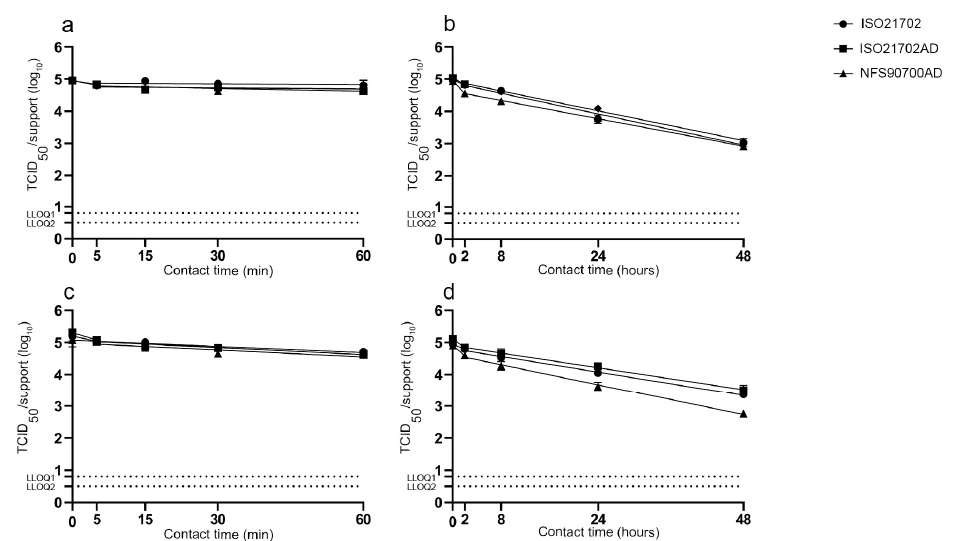
Figure 1. Survival of enveloped H3N2 virus ( a , b ) and non-enveloped feline calicivirus ( c , d ) on stainless steel reference surfaces according to ISO21702, ISO21702AD and NFS90700AD protocols. LLOQ: lower limit of quantification (LLOQ2 = 0.5 log 10 TCID 50 for 21702/21702AD methods and LLOQ1 = 0.8 log 10 TCID 50 for NFS90700AD method). Value displayed as average +/ − SD. The amount of H3N2 infectious virus on the AS01 surface reached the lower limit of quantification at 48 h post application, whereas no H3N2 infectious particles were quantified at 24 h post application on the AS02 surface using all three protocols (Figure 2a,c). ISO21702 and ISO21702AD protocols gave similar values for the amounts of virus observed on AS01 at both 2 and 8 h post application. As observed on stainless steel supports at 24 h post application, the H2N2 virus was statistically the most stable on AS01 under ISO21702AD experimental conditions (Figure 2a). The NFS902700AD protocol had an impact on the survival of the H3N2 virus on AS01, as shown by the significantly reduced amount of infectious virus over time as compared to those quantified using ISO21702 and ISO21702AD protocols. The same impact was observed at 15 min and 8 h post application for AS03 and AS02, respectively (Figure 2c,e). A difference of 1 log 10 TCID 50 was observed on AS03 at 15 min post application, between NFS90700AD and ISO21702 or ISO21702AD protocols (Figure 2e). The antiviral activities Rm (log 10 TCID 50 /cm 2 ) of the three active surfaces, corresponding to the difference in the logarithm of the infectivity titer of H3N2 virus found on stainless steel supports versus antiviral-treated, were determined over time. While the antiviral activity of AS01 at 2 h post application showed no significant difference among the three protocols, antiviral activities were significantly higher at 8 and 24 h post application using the NFS90700AD compared to the ISO21702/ISO21702AD protocols (Figure 2b). While all three protocols revealed similar antiviral activities for AS03 and AS02 at, respectively, 5 min and 2 h post application, a stronger antiviral activity for AS03 and for AS02 was revealed at, respectively, 15 min and 8 h post application using the NFS90700AD protocol (Figure